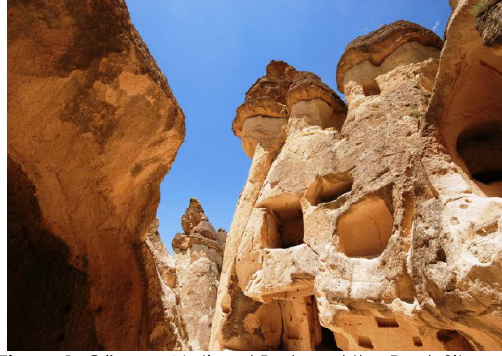
Figure 1 . Göreme National Park and the Rock Sites of Cappadocia (Unesco, 2019). 3.